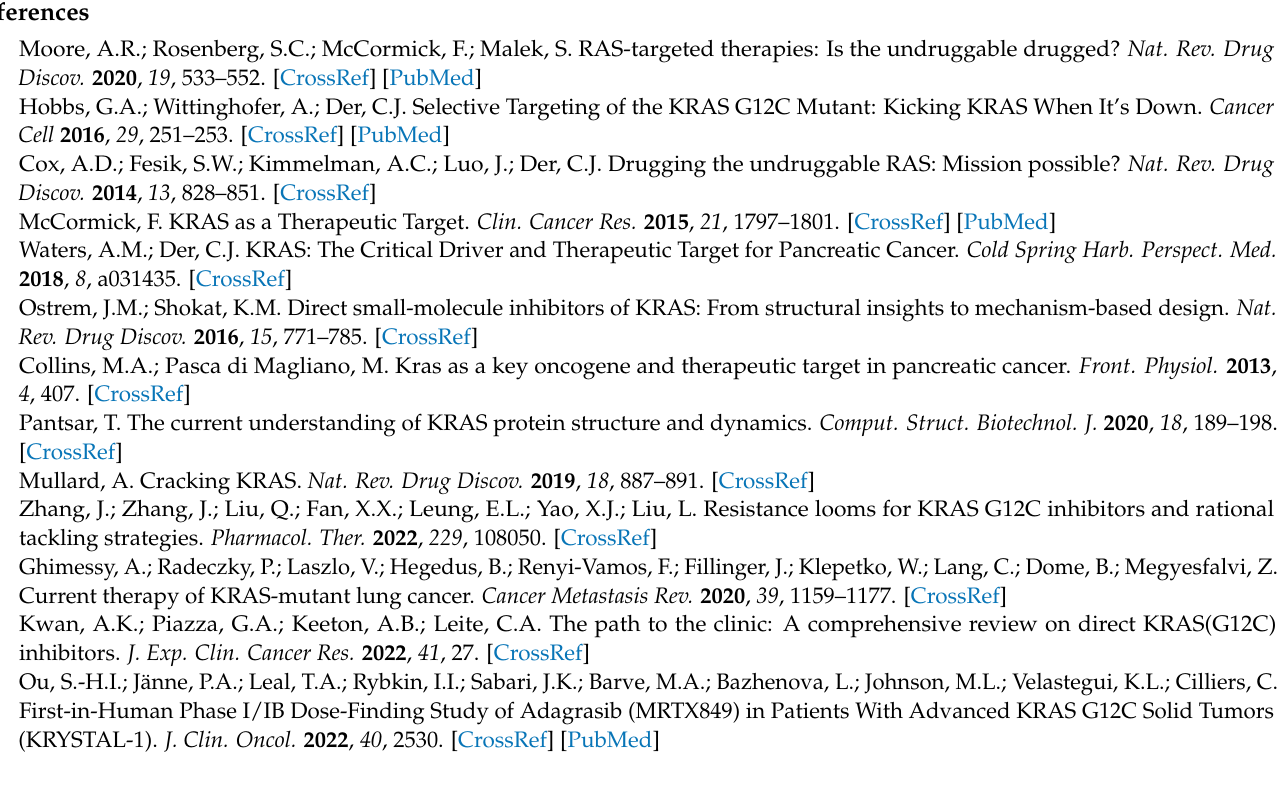
Figure S1: The monitored root-mean-square deviation (RMSD) of protein backbone atoms of the protein-ligand complexes during the MD simulation. Figure S2: The calculated binding free energy ( ∆ G cal ) for AMG510- and MRTX849-bound complexes. Figure S3: Pharmacophore models of AMG510 and MRTX849 binding to KRAS G12C, G12C-R68S, G12C-K16T, G12C-Y96C and G12C-Y96D. Figure S4: The equilibrium probability ( π i) of each metastable state in MSM. Figure S5: Superposition of representative conformations for Apo, AMG510- and MRTX849-bound